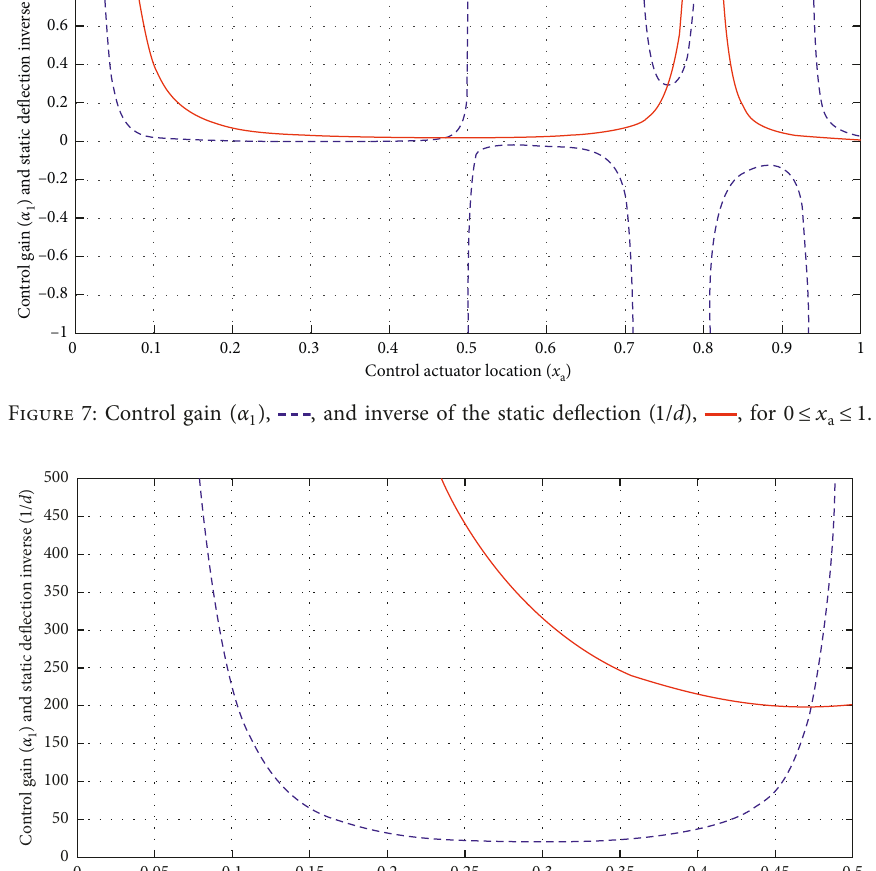
), , and inverse of the static deflection (1/ d ), , for 0 ≤ x 1